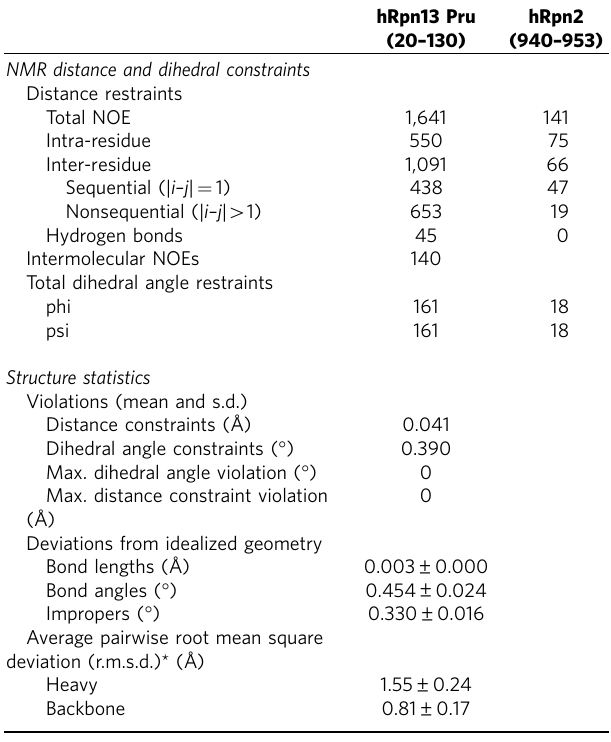
Table 2 | Structural statistics for the hRpn13 Pru-hRpn2